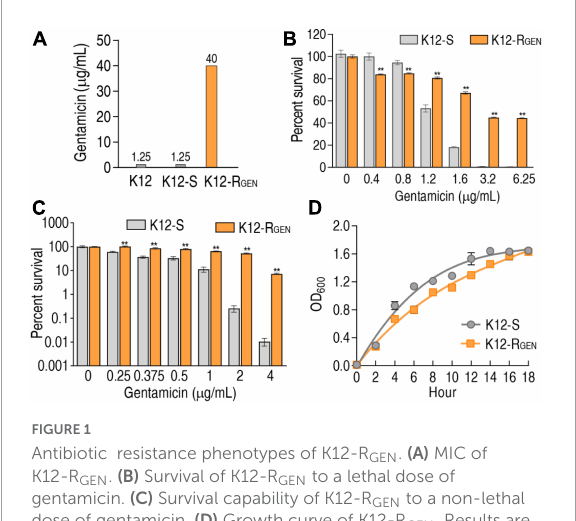
FIGURE1 Antibiotic resistance phenotypes of K12-R GEN . (A) MIC of K12-R GEN . (B) Survival of K12-R GEN to a lethal dose of gentamicin. (C) Survival capability of K12-R GEN to a non-lethal dose of gentamicin. (D) Growth curve of K12-R GEN . Results are displayed as mean ± SEM and three biological repeats are performed. Significant differences are identified. ** p < 0.01.